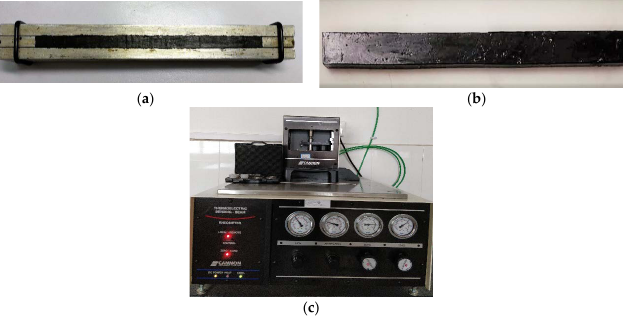
Figure 8. Thermoelectric bending beam rheometer (BBR) and specimen: ( a ) metal die of BBR; ( b ) asphalt beam of BBR; ( c ) thermoelectric bending beam rheometer.